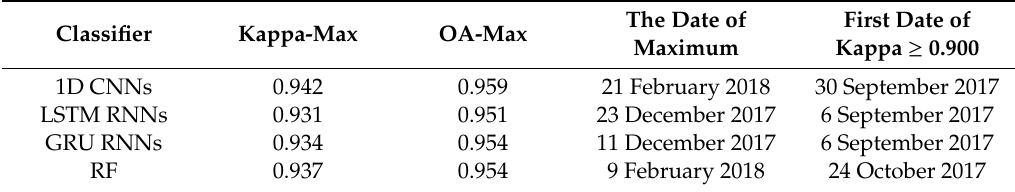
Table 4. A summary of Kappa coe ffi cients and the overall accuracies of the di ff erent classifiers. Bolded dates and values are the best results.